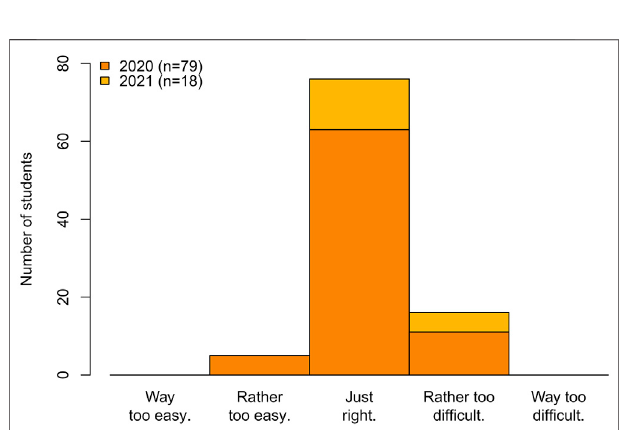
FIGURE3| Answerstothequestion “ Howwouldyouratethedif fi cultyof theexcursion? ” .Moststudentsconsideredthelevelofdif fi cultytobejustright. Only a few students found it rather too dif fi cult or rather too easy (results from the survey sent out directly after the excursion).